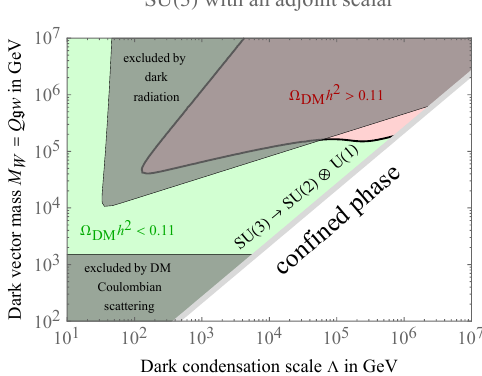
Figure 1 . We consider a typical model with DM charged under dark photons: one Higgs phase of gauged SU(3) with a scalar in the adjoint. The cosmological DM abundance is reproduced thermally around the boundary between the green (DM under-density) and red (DM over-density) regions. The regions in grey are excluded by the resulting dark radiation and Coloumbian scatterings among DM particles. The con(cid:12)ned phase of this model (in white) features no DM